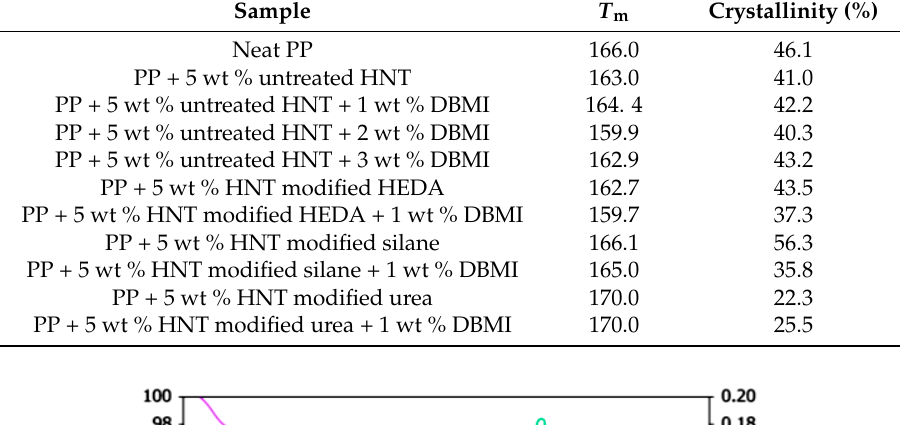
Table 4. Influence of 5 wt % of halloysite on PP crystallinity [82].